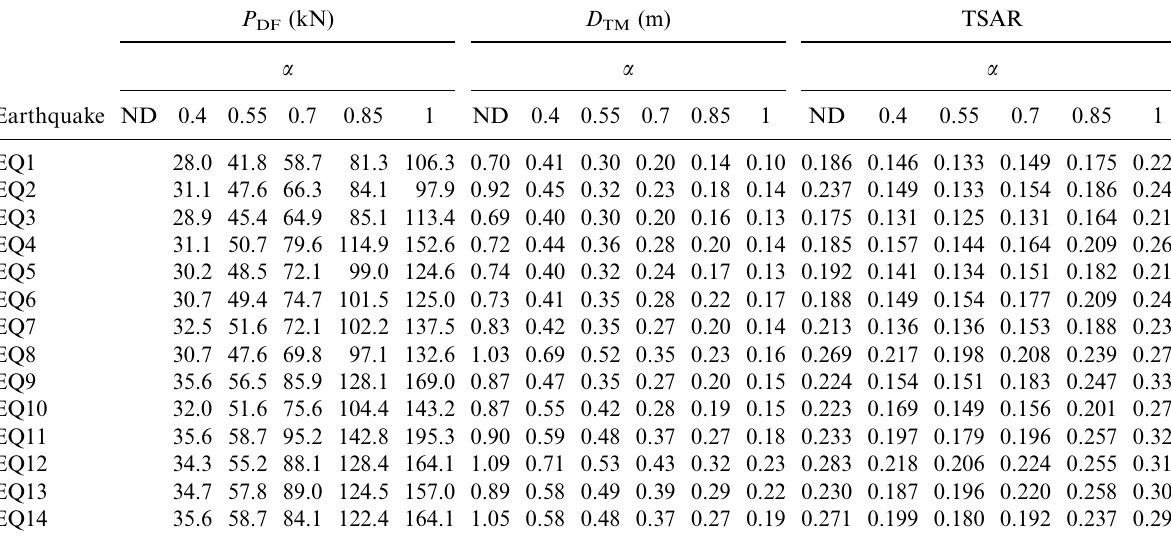
Table 4. Response parameters when C (cid:3) 263 kN-s/m P DF (kN)